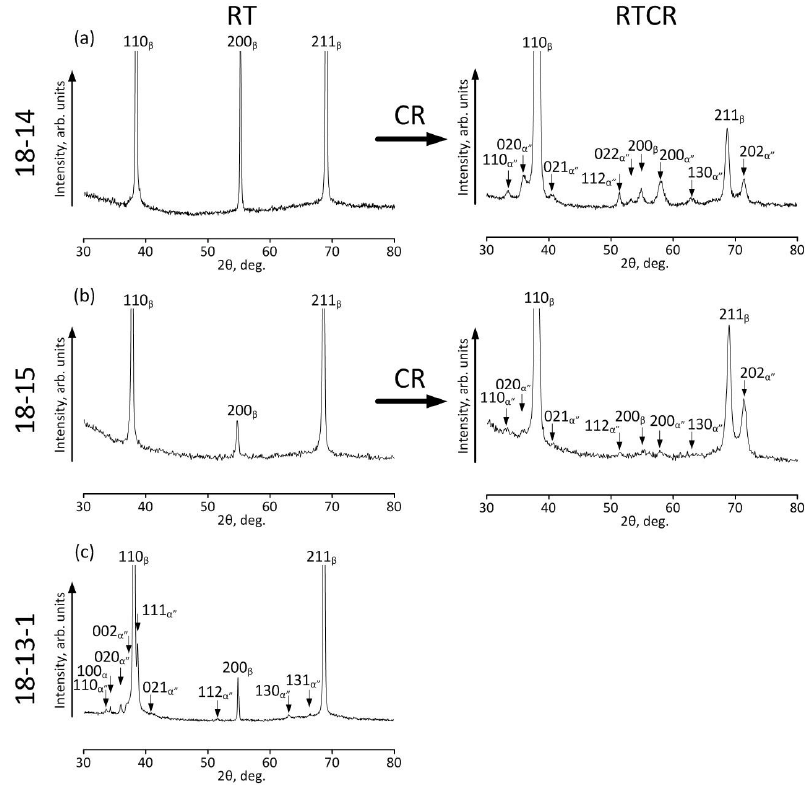
Figure 1. XRD profiles of ( a ) 18-14, ( b ) 18-15, and ( c ) 18-13-1 alloys after TMT, obtained at room temperature (RT) and after additional cold rolling deformation at room temperature (RTCR).